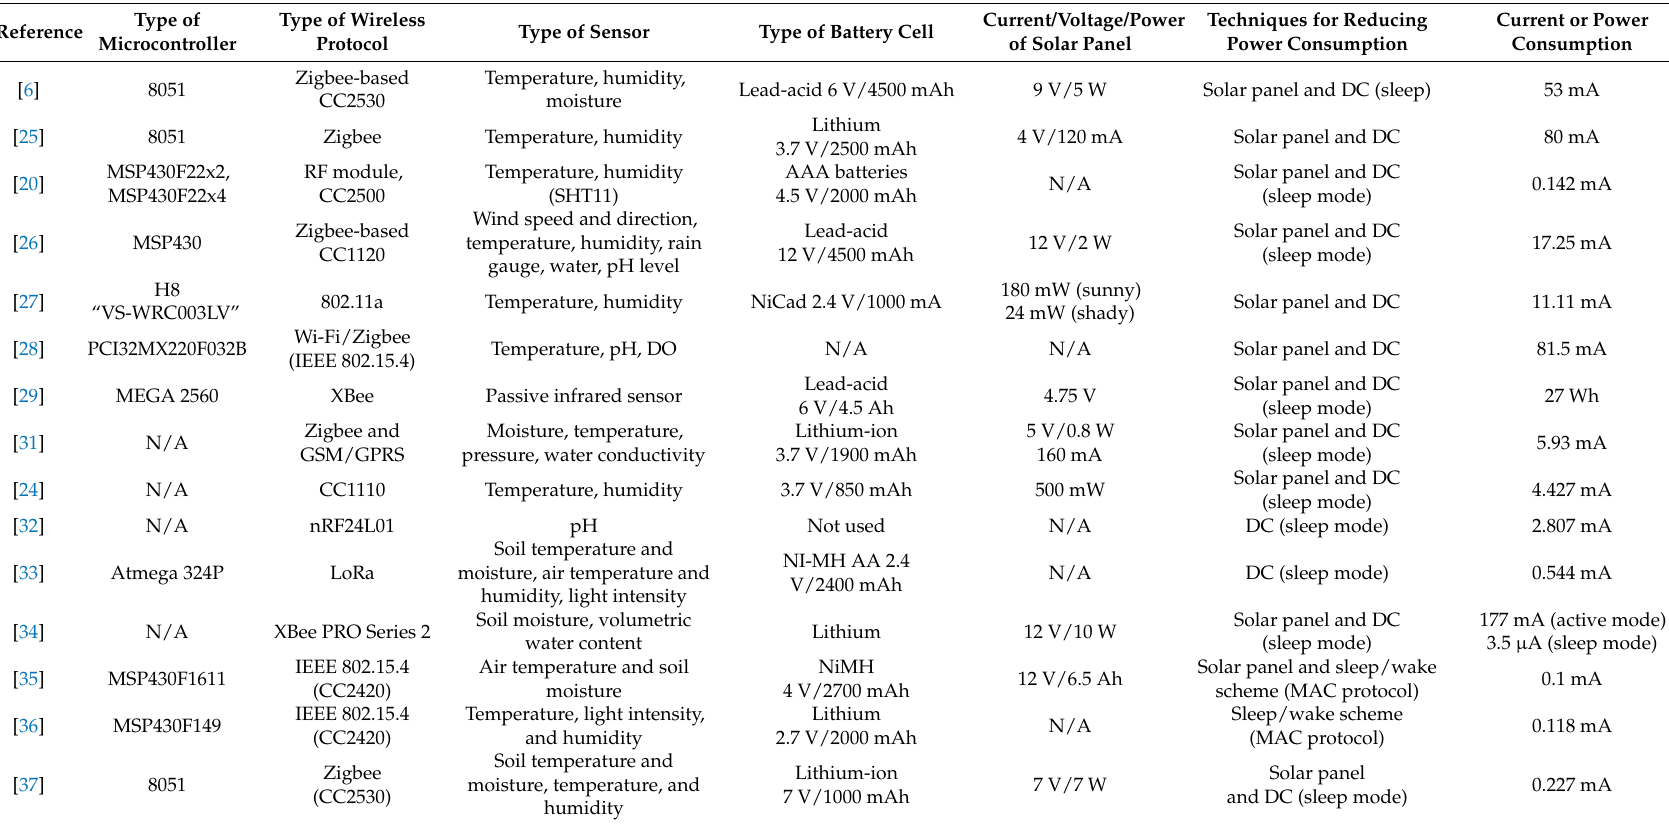
Table 1. Comparison between the current consumption of the proposed system and those of systems presented in previous research on agricultural applications.